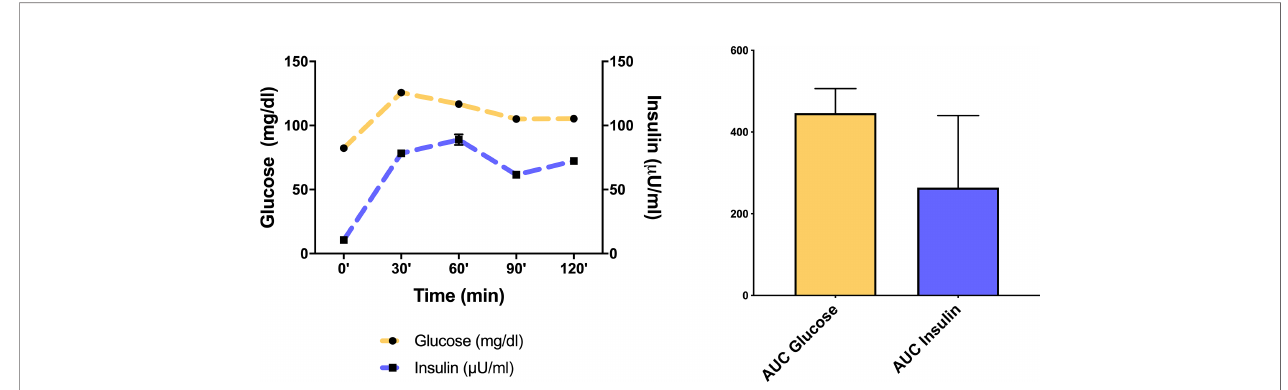
FIGURE 1 | Glucose and insulin curve at 0 ’ , 30 ’ , 60 ’ , 120 ’ minutes after oral glucose load and mean ± SD area under the curve (AUC) of glucose and insulin in the obese/overweight children